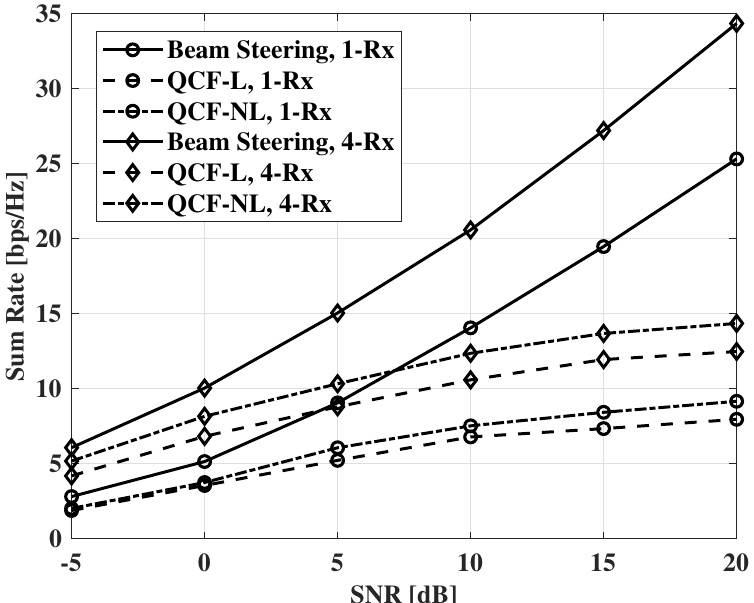
Figure 9. Sum rate measurements according to SNR, codebook size = 8 bits, N t = 64, N RF = 4, and N r =